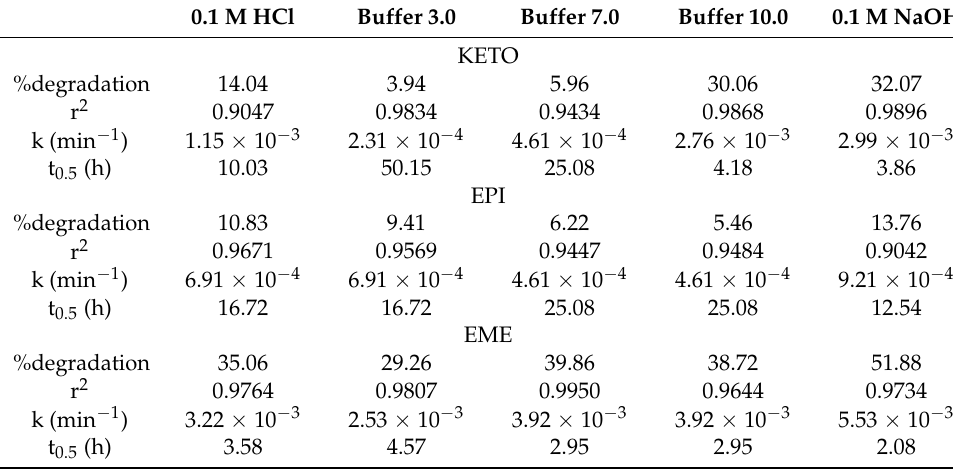
Table 2. Percentage degradation and kinetic parameters for ketotifen (KETO), epinastine (EPI) and emedastine (EME) in solutions of different pH at 70 ◦